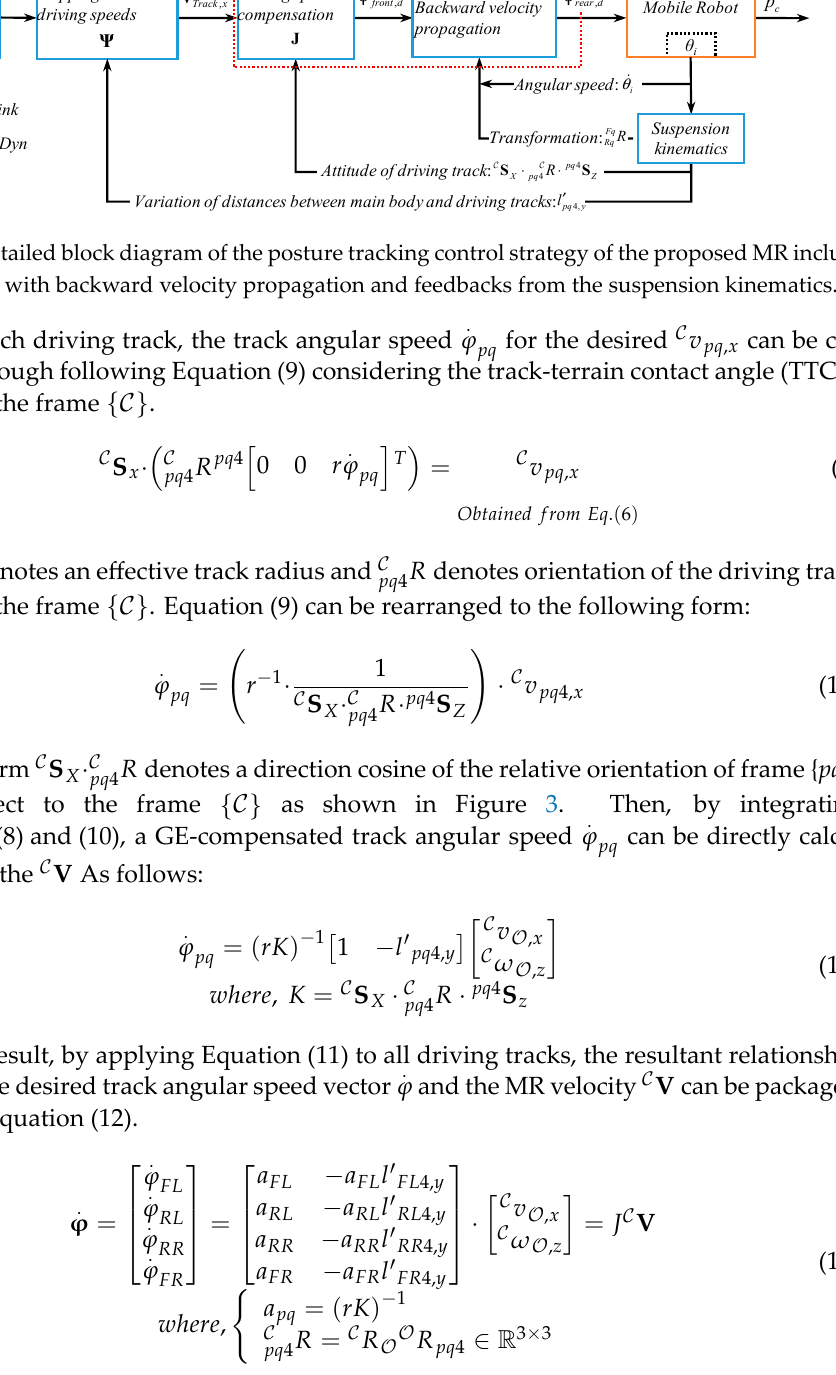
where, r denotes an effective track radius and 𝑅 (cid:3043)(cid:3044)(cid:2872)𝒞 denotes orientation of the driving track relative to the frame {𝒞} . Equation (9) can be rearranged to the following form: